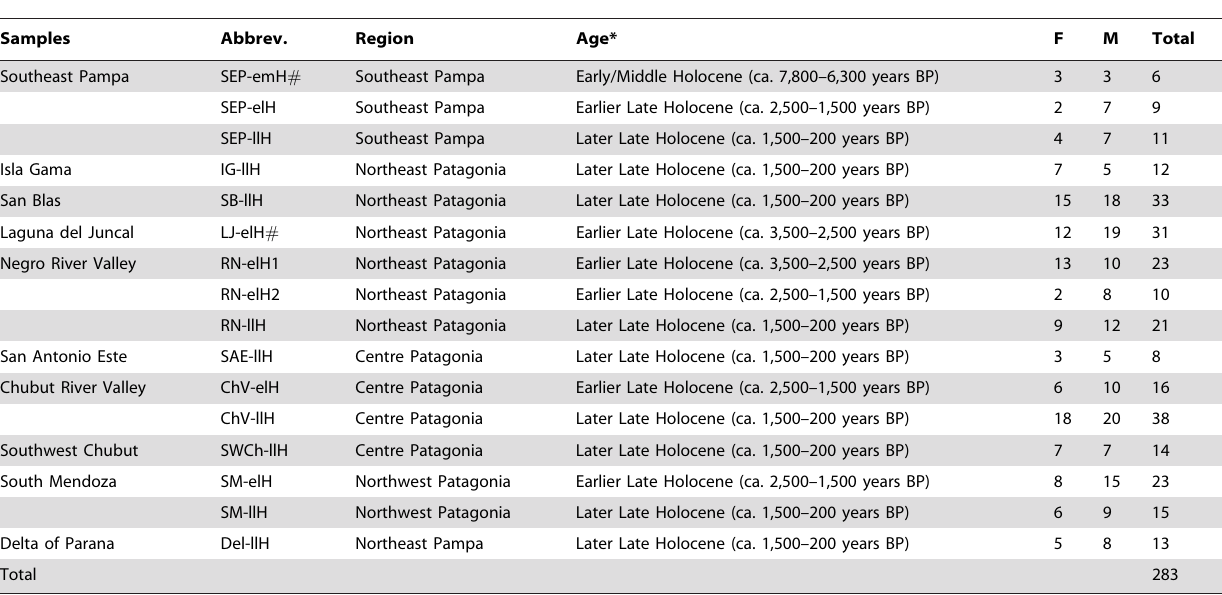
Table 1. Sample composition, abbreviations, age, gender distribution and sample sizes.